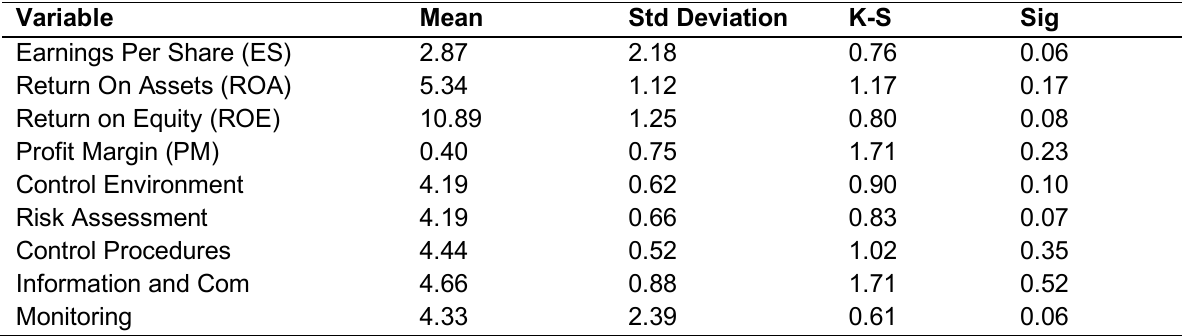
Table 1: Test for Normality of